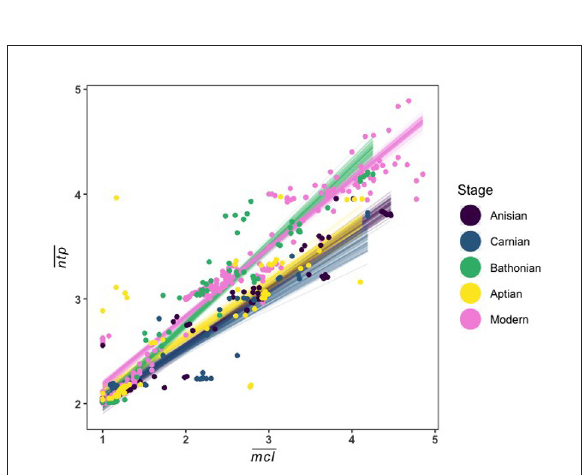
FIGURE7 Linear fit lines from 100 MCMC draws relating guild mean ntp and mcl for all Mesozoic communities and a modern Jamaican coral